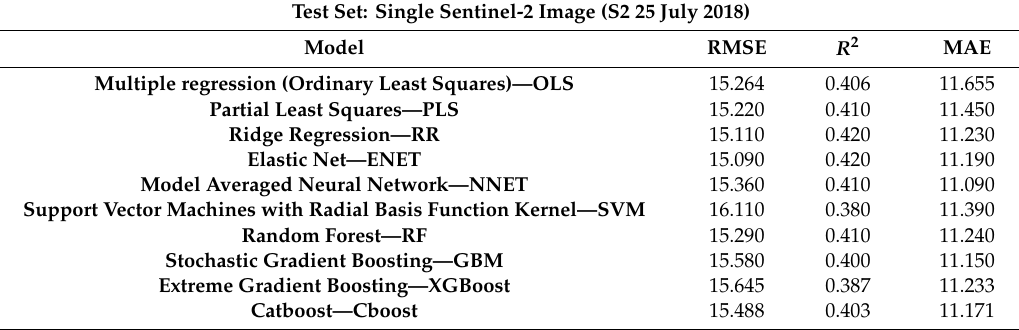
Table 5. Model validation on the testing set: a single S-2 image (S2 25 July